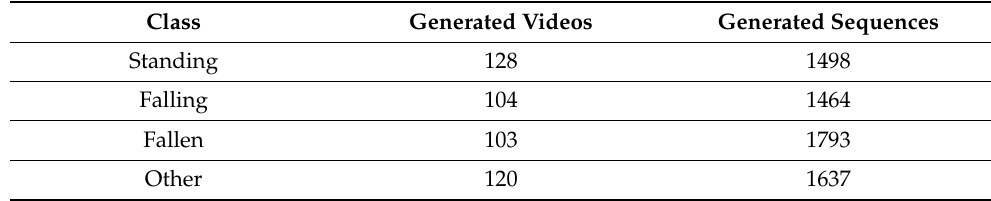
Table 2. Dataset